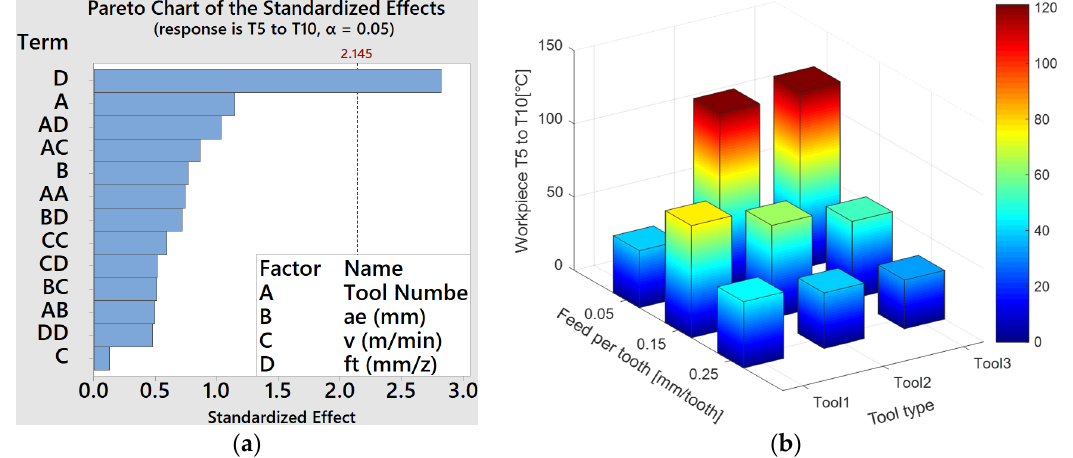
Figure 10. ( a ) Pareto chart of the standardized effects for T5 to T10; ( b ) 3D bar effect graph for T1 to T4.